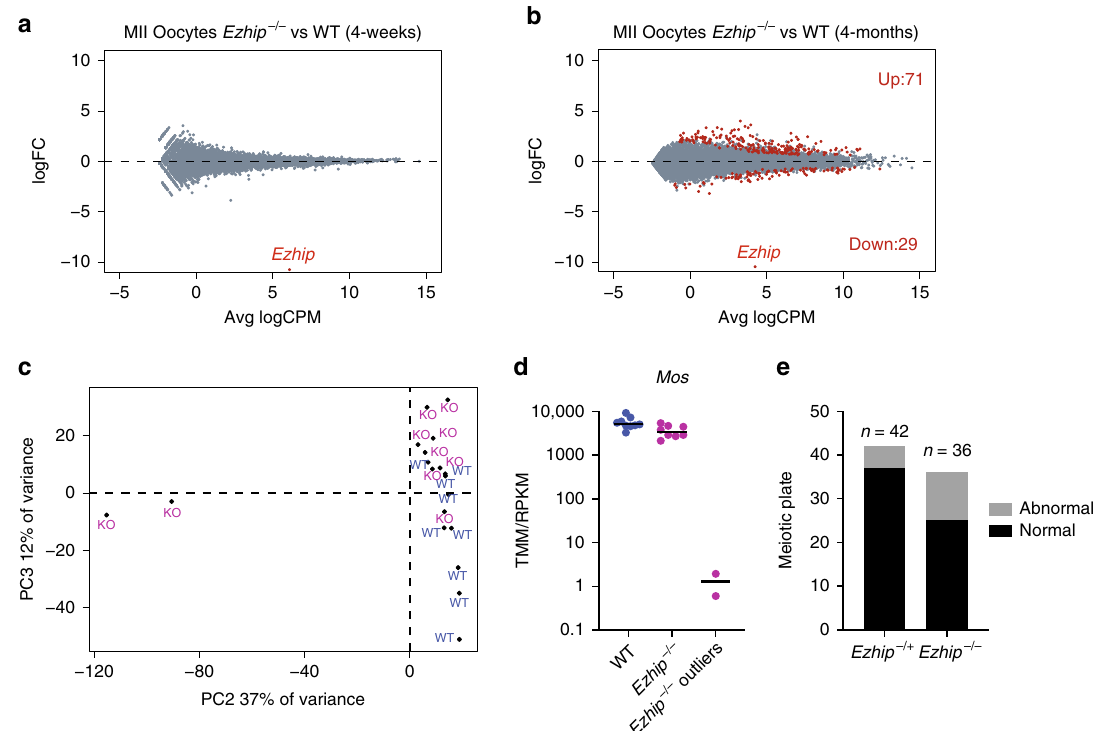
Fig. 7 Characterization of Ezhip − / − oocytes. a Mean-difference plot showing log2 fold-change (logFC) expression vs. average log2 counts per million (logCPM) for MII oocytes obtained from 4 weeks Ezhip + / − and Ezhip − / − superovulated females, n = 2 (each n is a pool of two individual animals). b Expression vs . log2 fold-change (logFC) expression vs. average log2 counts per million (logCPM) for MII single oocyte obtained from 4-month-old Ezhip + / − and Ezhip − / − superovulated females, n = 9 for WT and n = 10 for Ezhip − / − . Oocytes originated from two different mice for WT and 3 for Ezhip − / − . c Principal components analysis of each individual oocyte transcriptome. d Mos expression according to the single oocyte RNAseq included in ( c ). e Chromosome abnormalities evaluated as a proportion of matured MII stages oocytes that exhibited normal alignment of chromosomes on spindle vs. matured MII stages oocytes